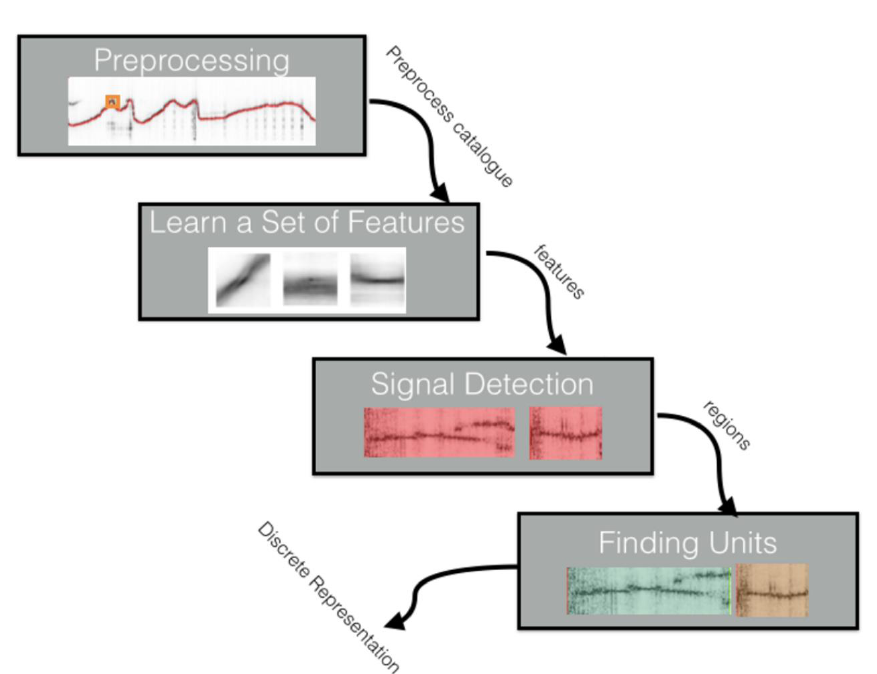
Figure 1. Our dolphin signal processing pipeline. Audio files containing only dolphin vocalizations are converted to spectrograms. The spectrogram around the dolphin vocalizations are divided into patches approximately 1 ms in time and 1 kHz in frequency. These patches are clustered, and the top 60 most common are used as features to segment dolphin vocalizations into regions. The features are also used as the basis for hierarchical clustering to identify units in these regions. These units provide a discrete representation of the dolphins’ vocalizations, and we align these discrete representations to extract a set of regular expressions. We have used these regular expressions to predict the labels biologists give the dolphins’